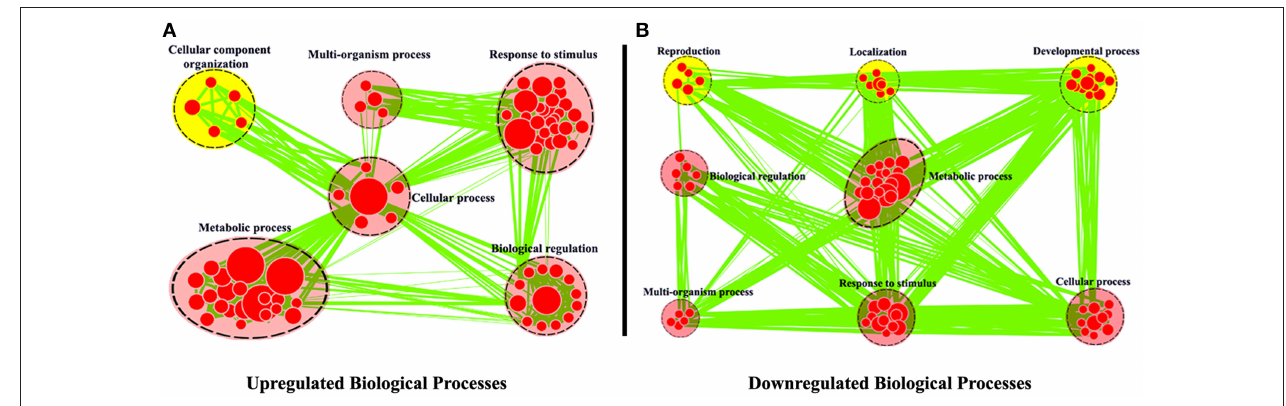
FIGURE 1 | Biological process analysis of differentially expressed genes between leaf and root tissues. GO modules enriched with up-regulated DEGs (A) and down-regulated DEGs (B) were visualized by the EnrichmentMap in Cytoscape. The red and yellow circles indicate the common and different biological processes between up-regulated and down-regulated DEGs, respectively (From the article Wu et al.,